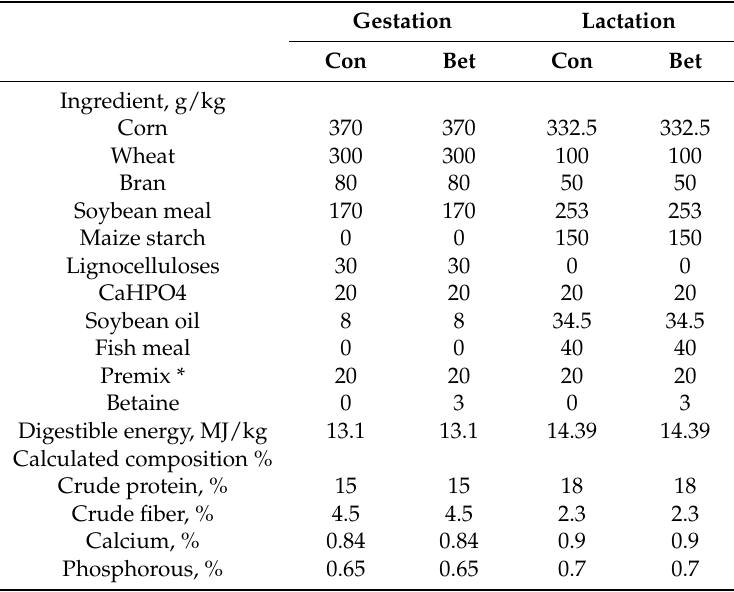
Table 1. Composition and nutrient content of the experimental